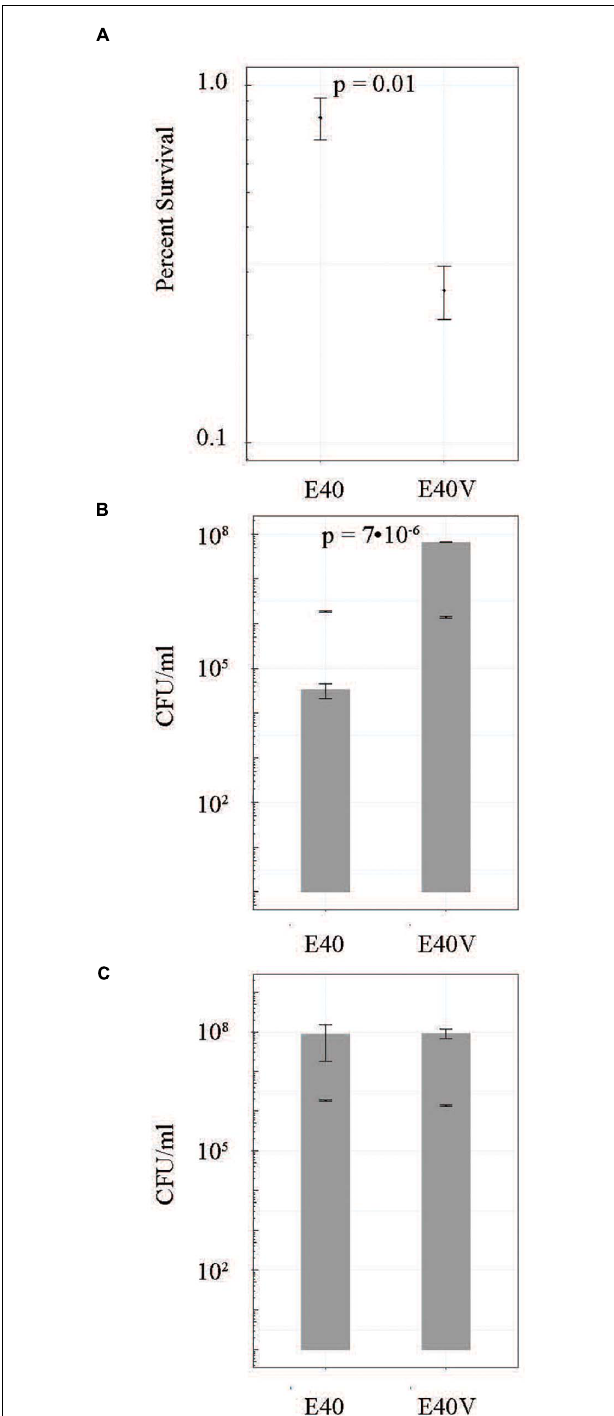
FIGURE 3 | E40 and E40V survival and growth in TSB with 10% bile salts when inoculated at approximately 10 6 CFU/ml. (A) Cells were incubated at 37 ◦ C for 3 h and the percent survival was calculated from CFU/ml determinations. (B) CFU/ml of E40 and E40V after 16 h of incubation. The bars represent CFU/ml following inoculation. (C) CFU/ml after 20 h of incubation. The bars represent CFU/ml following inoculation. N =3 for all time points. Error bars are the standard error of the mean.